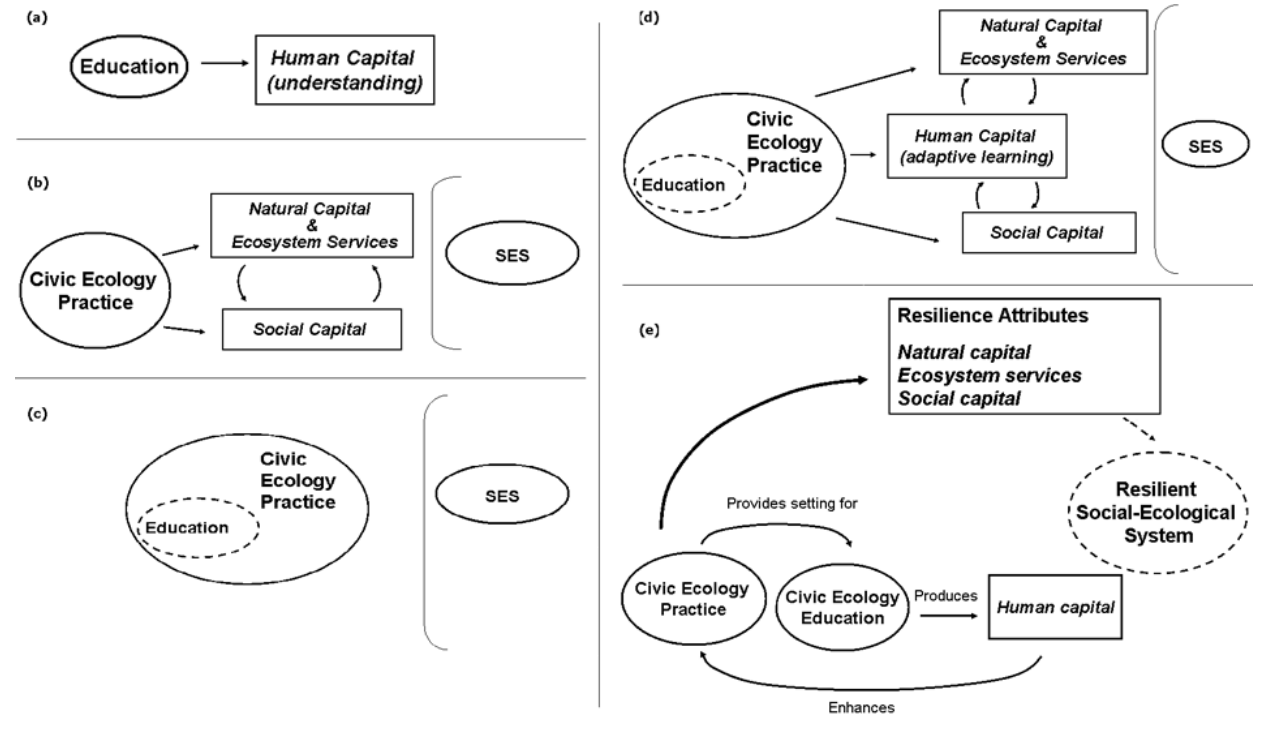
Fig. 4. Education, civic ecology practice, and social–ecological system resilience. Series of figures showing how an educational program embedded within civic ecology practice, along with the civic ecology practice itself, can confer social–ecological system resilience. (a) A traditional view of education emphasizes its role in producing greater understanding of a predetermined body of turn produces ecosystem services (e.g., carbon sequestration, recreation). By community